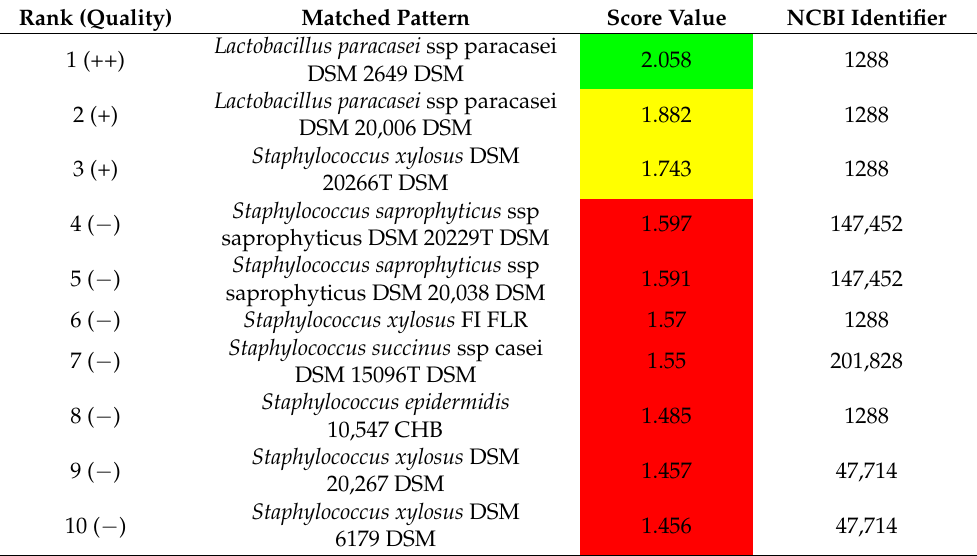
Meaning of Score Values: Green color with the symbol (++) and the score range from 2 to 2.299 refer to secure genus identification, probable species identification. Yellow color with the symbol (+) and the score range